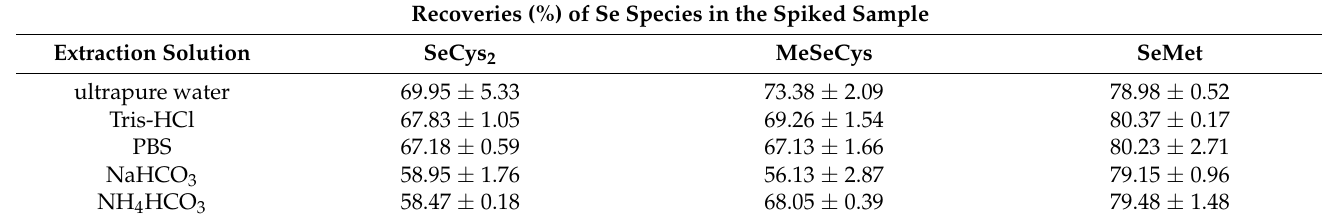
Table 1. Concentration and spike recoveries of SeCys 2 , MeSeCys, and SeMet in eggs using different extraction solution (Results expressed as the mean ± standard deviation (SD)).